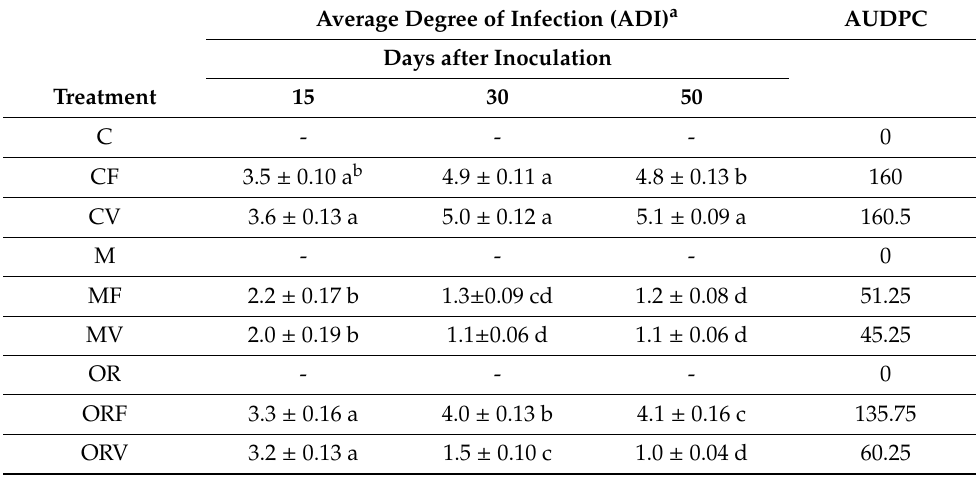
Table 6. Average degree of infection (ADI) ( ± se) and area under diseases progress curves (AUDPC) of transplanted tomatoes grown in soil amended with 4% ( w / w ) of spearmint or oregano plant material. Determination was made at 15, 30 and 50 days after inoculation which coinciding with the days after seedling transplantation (DAT). Full description of the treatments examined is found in Table 1. Average Degree of Infection (ADI) a AUDPC Days after